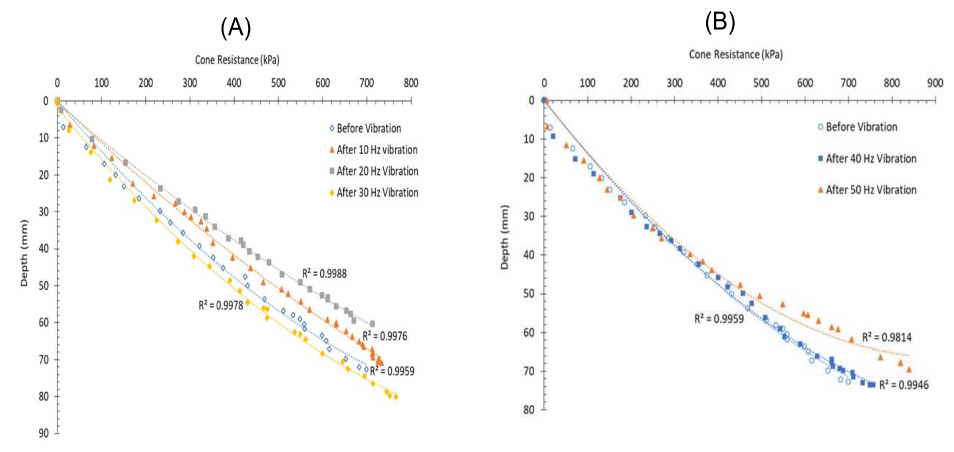
Figure 6. Cone resistance obtained from digital SCP data for confined granular fill with and without excitation frequency of ( A ) 10–30 Hz; ( B ) 40–50 Hz.